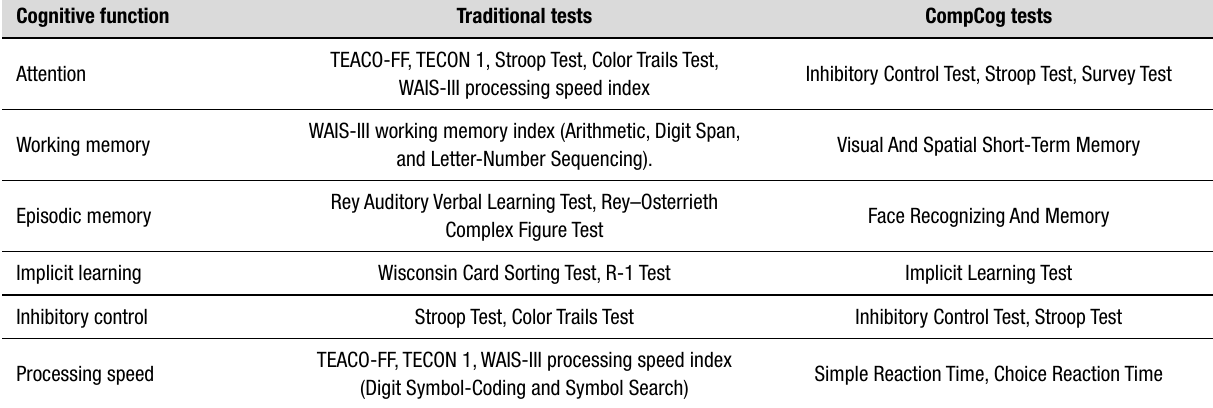
Table 3. Cognitive functions measured by traditional tests and predicted